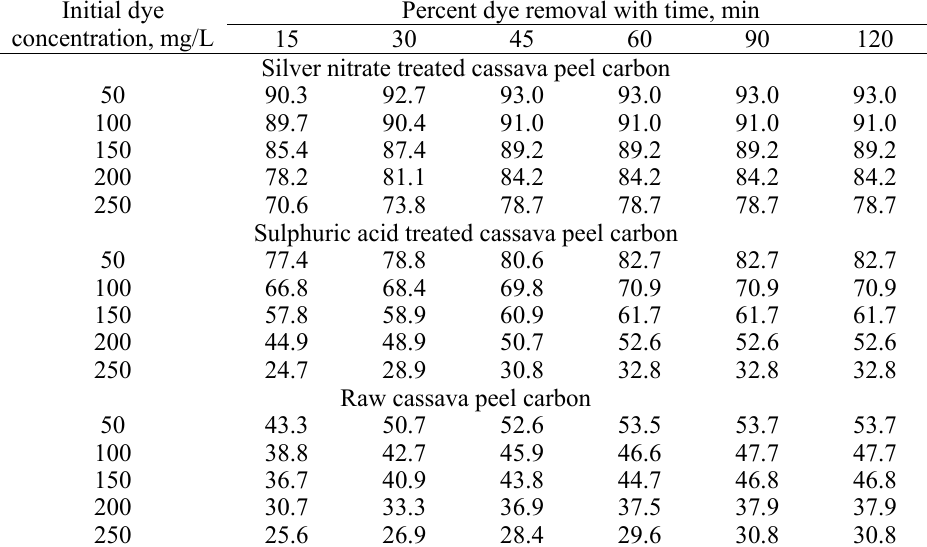
Percent dye removal with time, min Initial dye